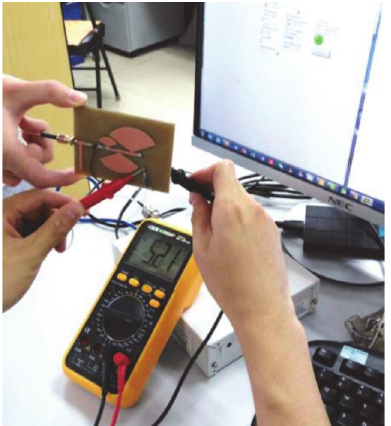
Figure 16: Experiment to validate the performance of proposed system. Table 2: Comparison of conversion efficiency of different rectennas. Rectenna